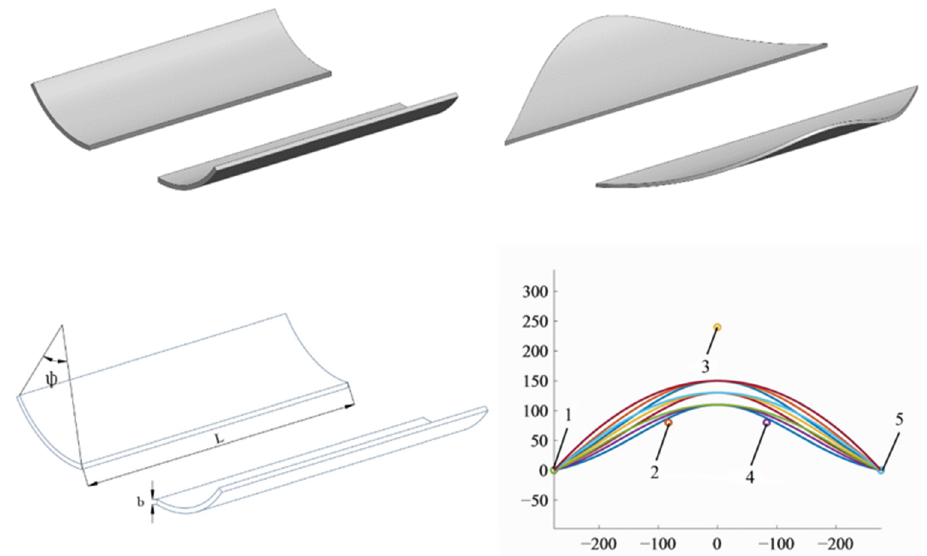
Figure 3. The fluid domain.